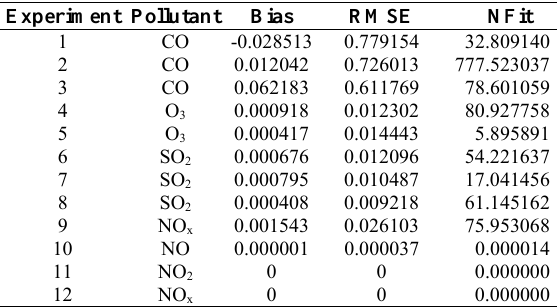
Table 4. Experimental results of the first generation (ppm).